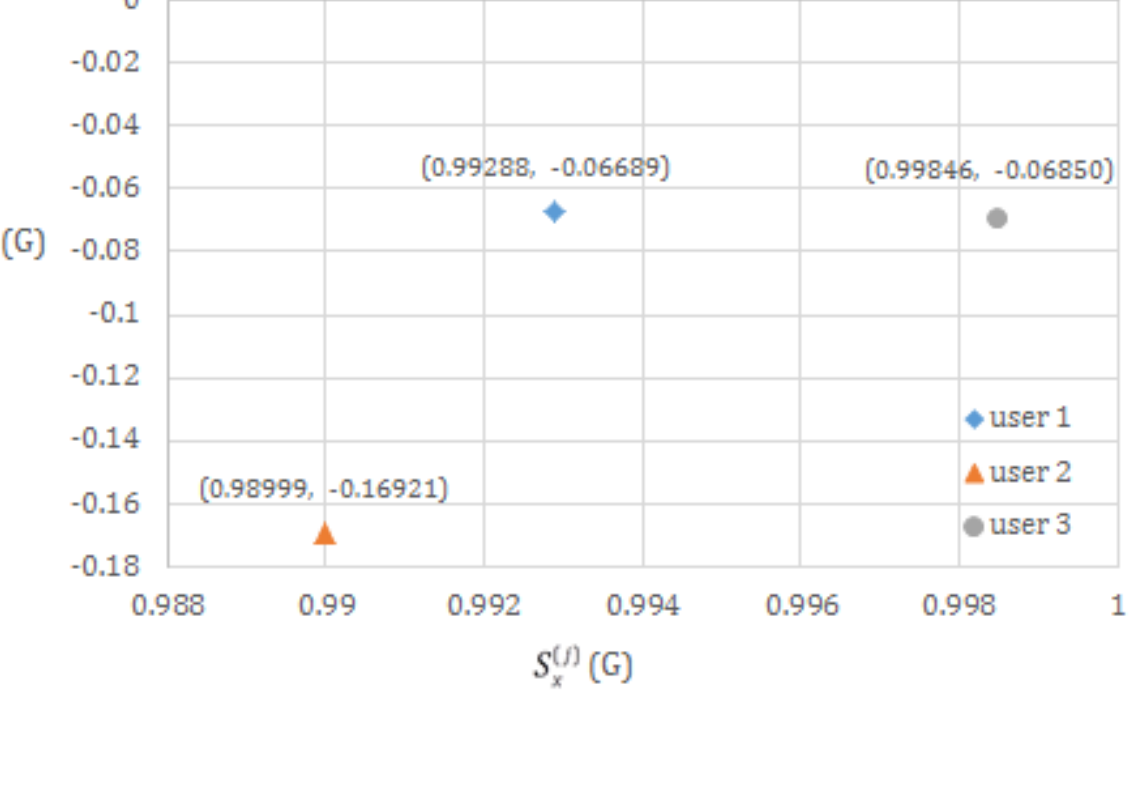
Figure 17. Distribution of the standard values of the 3 users (who were tested) across a 2-dimensional scatter